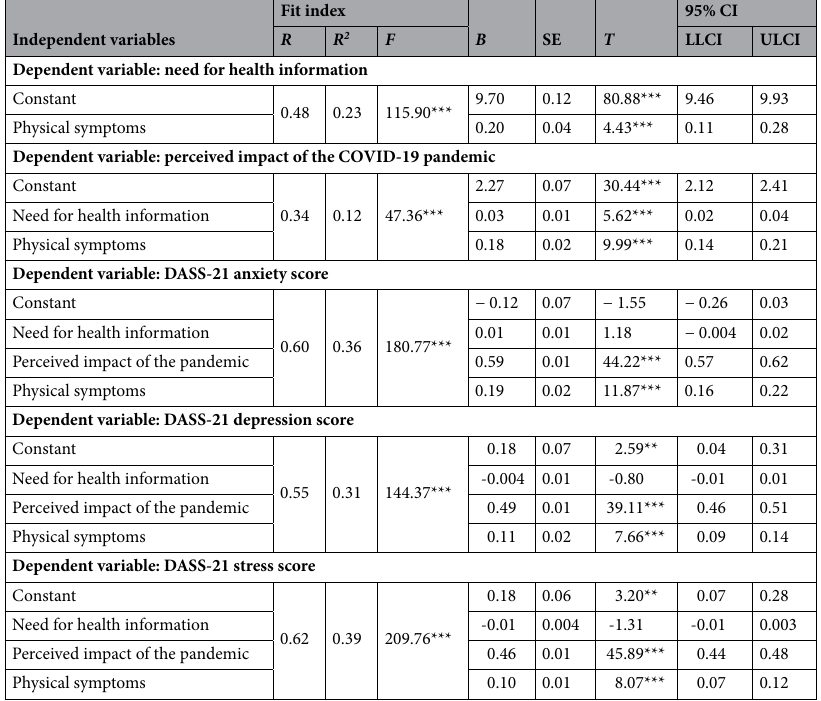
Poland (mean = 13.98, SD = 0.32) and Spain (mean = 13.93, SD = 0.39) were the three countries with highest DASS-21 stress scores. There were significant differences in DASS-21 stress scores among 8 countries ( F (7,